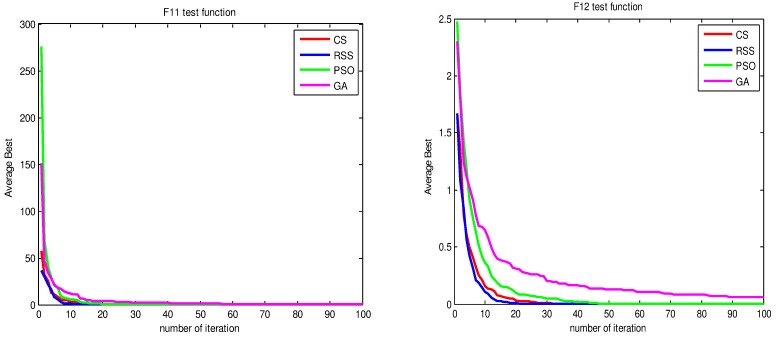
AB convergence of CS, RSS, PSO and GA for minimization of (a) F11 and (b) F12.